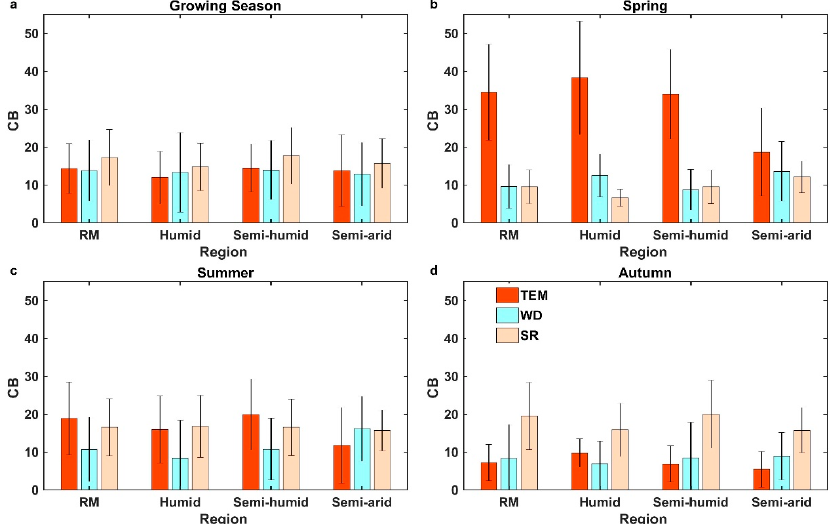
Figure 6. The relative contributions (CB) of TEM, WD and SR to variations in NDVI in different seasons in the whole study region (RM) and different drought gradients. ( a – d ) is for growing season, spring, summer and autumn, respectively. The relative contribution was calculated by averaging all values in pixels within the whole study region and the three categories of MAI. Black lines on bars in this figure are error bars.